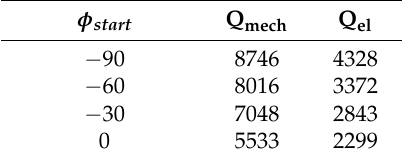
Table 1. Table of Q-factors obtained by optical and electrical measurements when applying a frequency-dependent, phase-shifted stimulus to the MEMS cantilever.